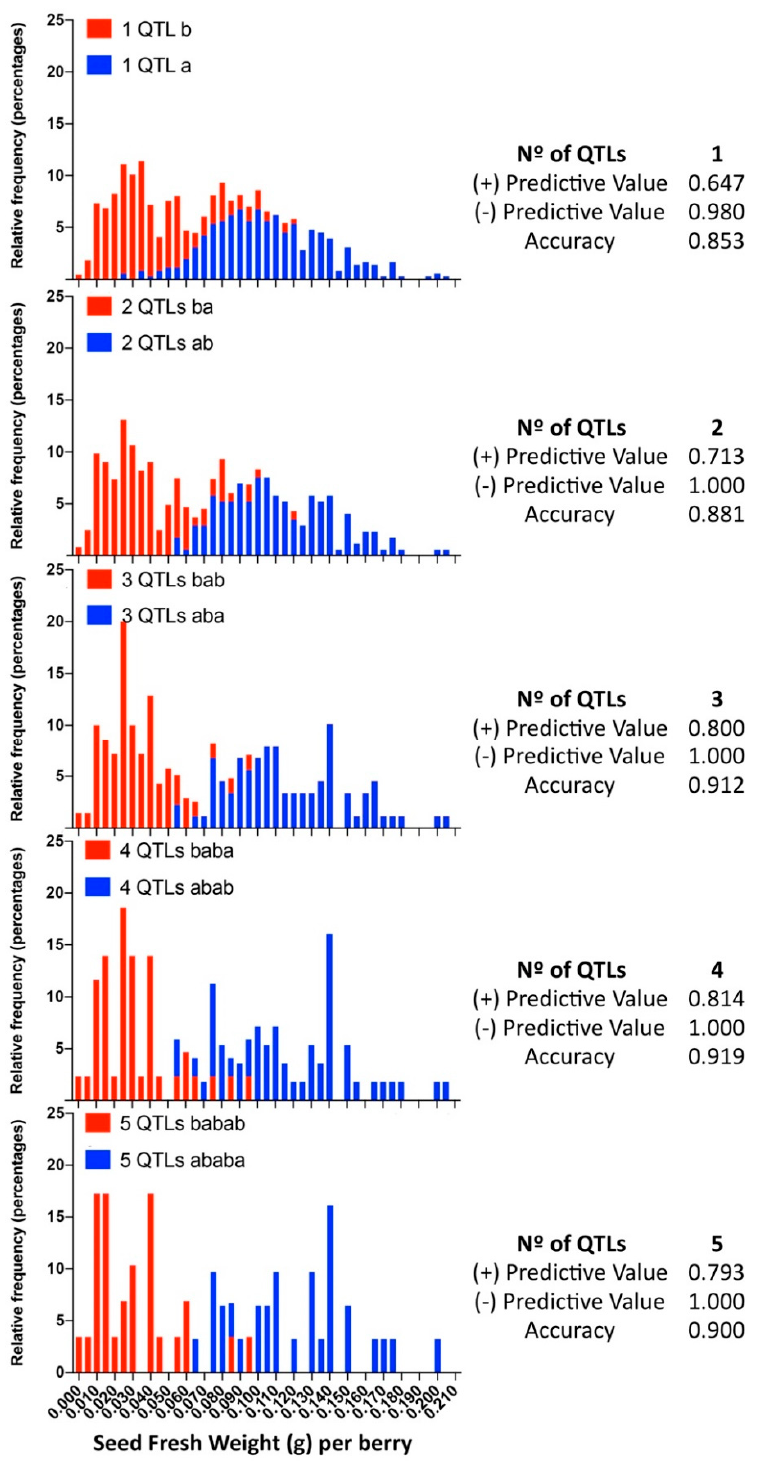
Figure 9. Frequency distribution of the MA × CS subpopulation sets selected by the most favorable alleles combining one to five QTLs. For each QTL, the most favorable allele combination is defined in Table 2, and the relative frequency of individuals is shown in red bars. Blue: the individuals selected by the opposite allele combination. The positive and negative predictive values were calculated from contingency tables (not shown).